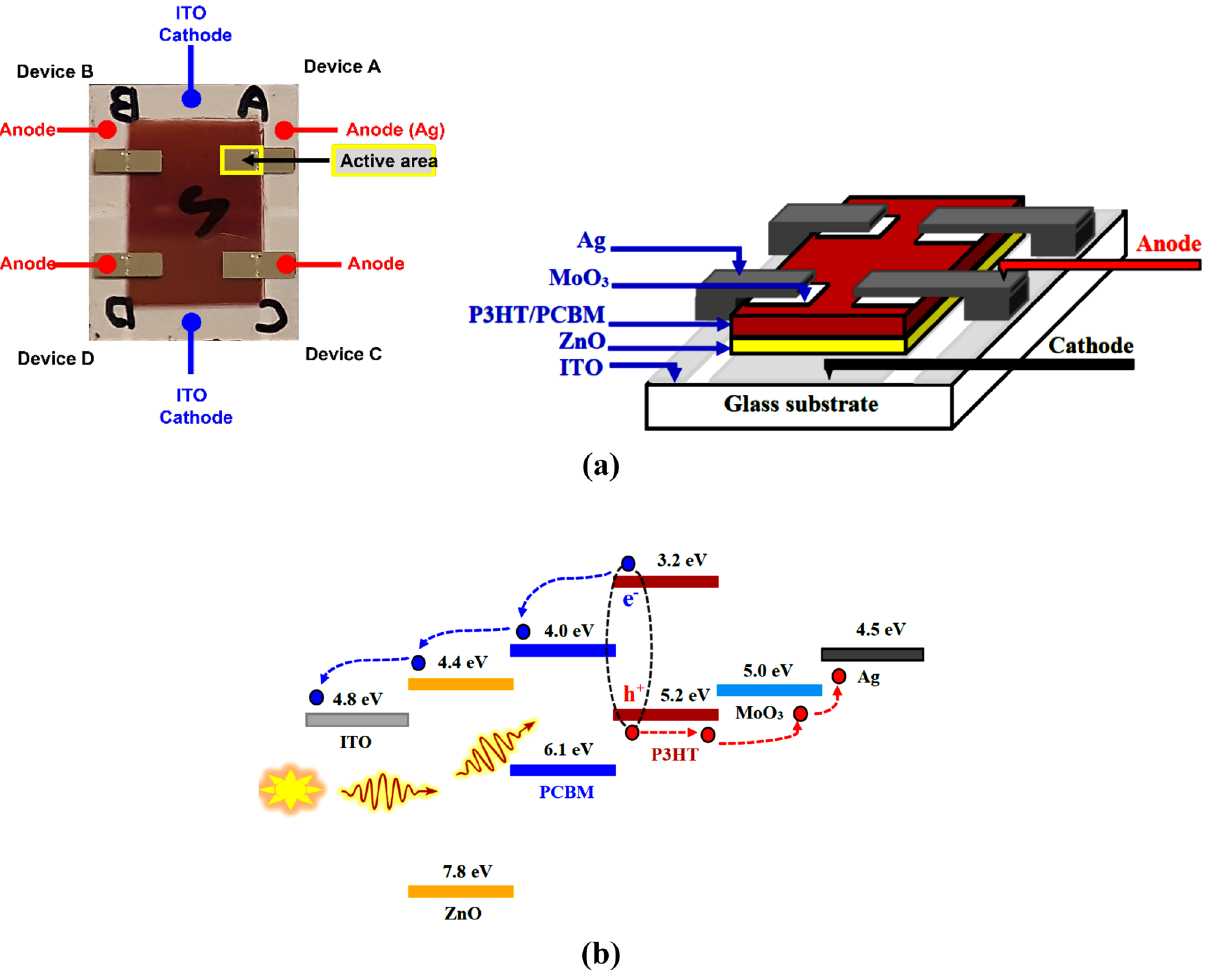
Figure 2. ( a ) The device representation of inverted BHJ organic solar cell, ( b ) Schematic description of energy level diagram of the inverted solar cell device.